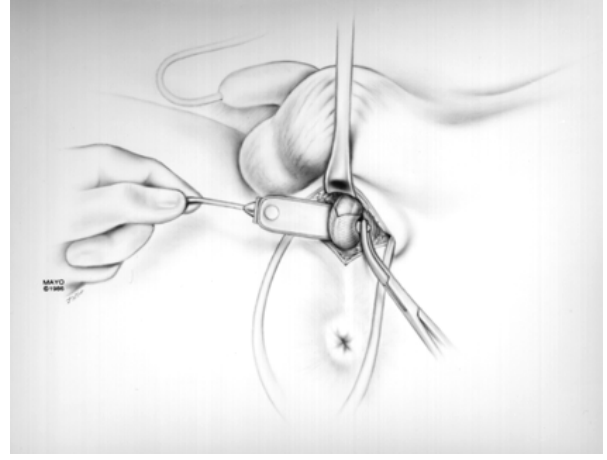
FIGURE 4. Passing the cuff around the bulbous